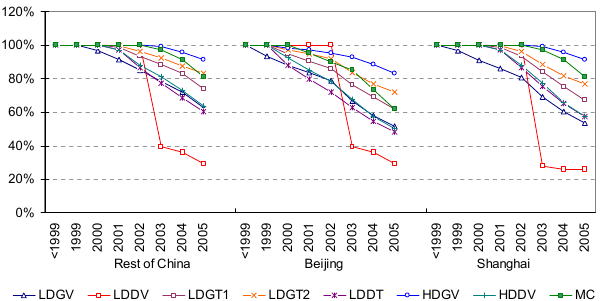
Fig. 4. Trends of net EF of PM 2 . 5 from on-road vehicles. All data are normalized to the year 1999.